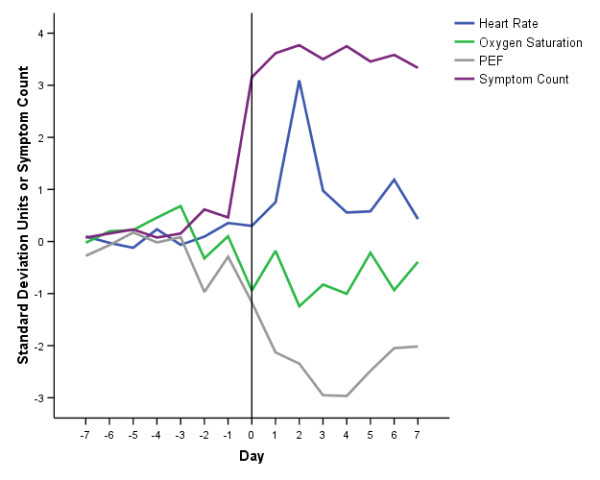
Time Course of Symptoms and Oximetry Variables at Exacerbation. Time course of symptom count, heart rate, oxygen saturation (SpO2) and peak-expiratory flow (PEF) from seven days prior (-7) to exacerbation onset (day 0, vertical line) and seven days into exacerbation of COPD. Values of the physiological variables are the mean of 13 exacerbations in 13 patients, expressed as standard deviation multiples away from each patient's stable mean (see text for details). A 1SD change is an approximate alteration in heart rate of 5 min-1, SpO2 of 1% and PEF of 10l min-1. Symptom count values are the mean from the 13 patients.